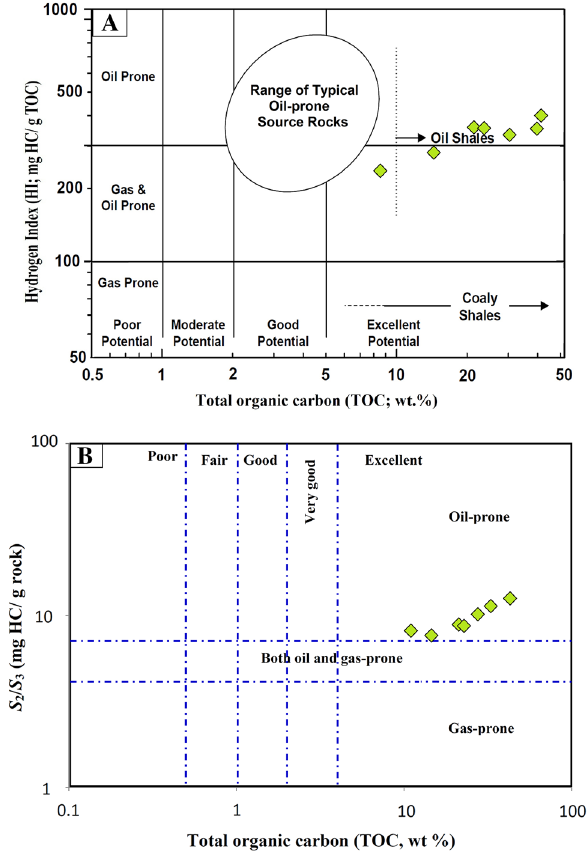
Fig. 12 Geochemical correlations between TOC content and Rock– Eval data (i.e., HI and S 2 / S 3 ) parameters], implying that the analyzed bituminite shale samples are both oil- and gas-prone source rocks, with highly oil generation